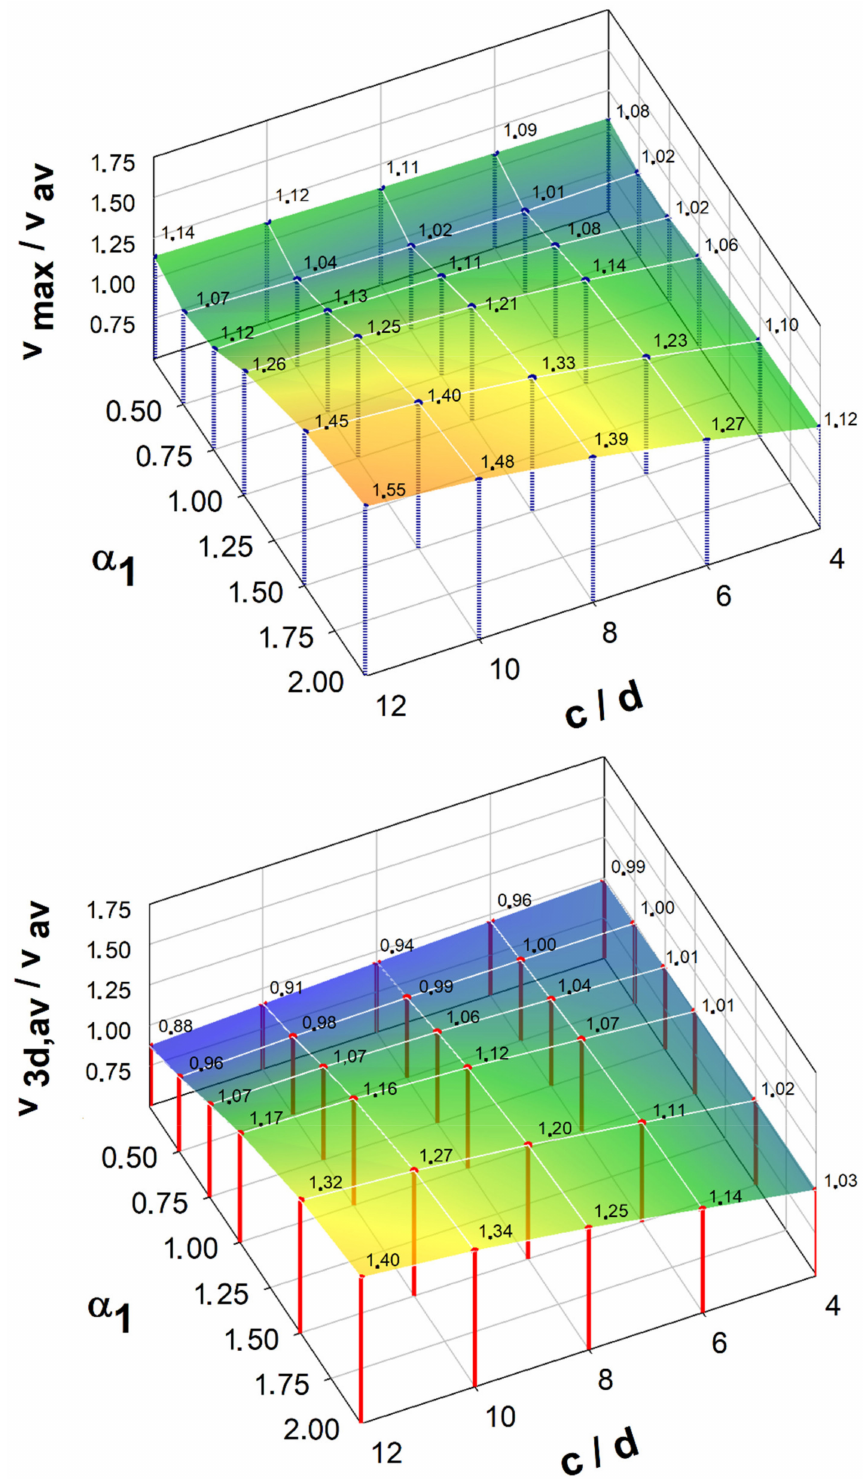
Figure 11. Influence of the dimensions of the shear caps and their stiffness on the distribution of shear forces in the control perimeter located at a distance of 2.0 d from the face of the shear